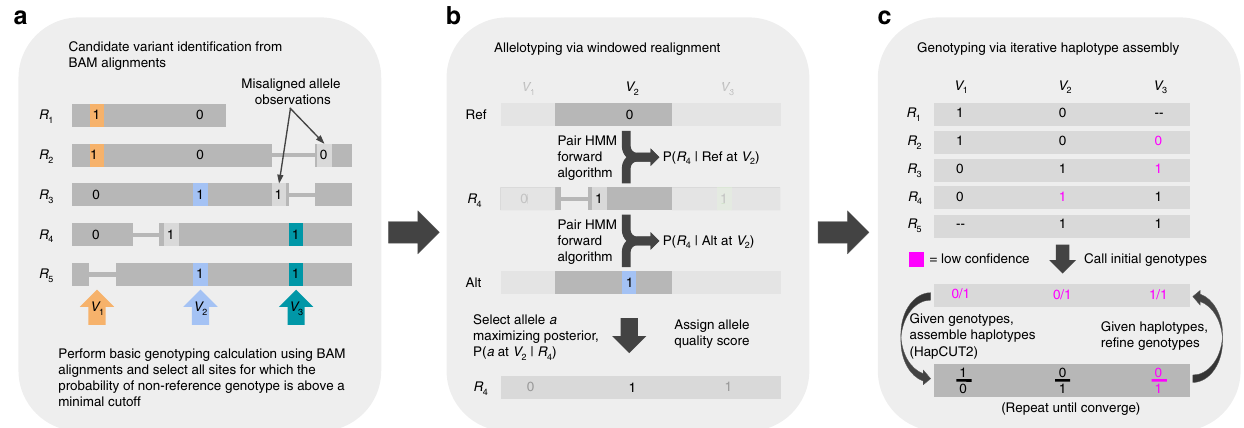
Fig. 1 Overview of the Longshot algorithm. a Candidate variants are identi fi ed using the pileup of the original alignments and a standard genotype likelihood calculation is used to determine whether the site is a potential variant. b To determine the allele for each read at each potential SNV site it overlaps, a window is formed around the variant and the probability of the observed read sequence given each allele is calculated using the forward algorithm on a Pair-Hidden Markov Model. The most likely allele and quality score is chosen based on the relative likelihoods of the two alleles. c Using the alleles and quality values for each read at variant sites, phased genotypes for all variants are determined jointly by performing haplotype assembly using HapCUT2 (on heterozygous variants) and local updates of the phased genotypes in an iterative